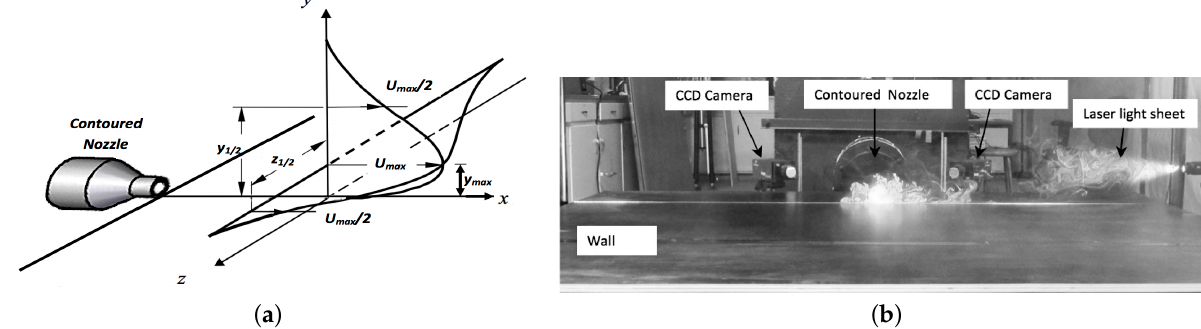
Figure 1. ( a ) Experimental setup of a three-dimensional wall jet issuing from a contoured nozzle and ( b ) the laser and particle image velocimetry (PIV) camera arrangement in the experimental